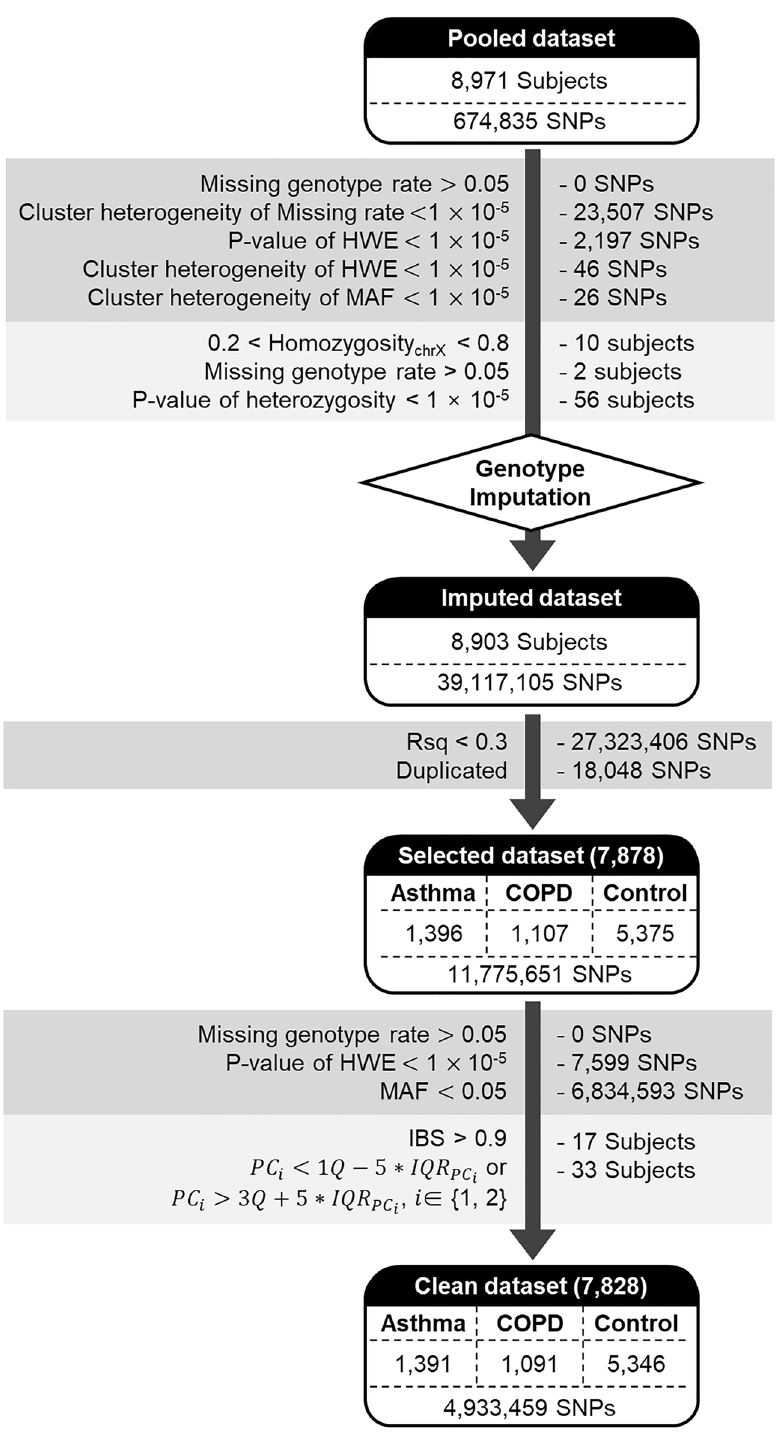
Figure 1. Workflow for the asthma-COPD GWAS using the Korean dataset. Multiple standard quality controls were performed for the asthma, COPD, and control groups to exclude outlier SNPs and